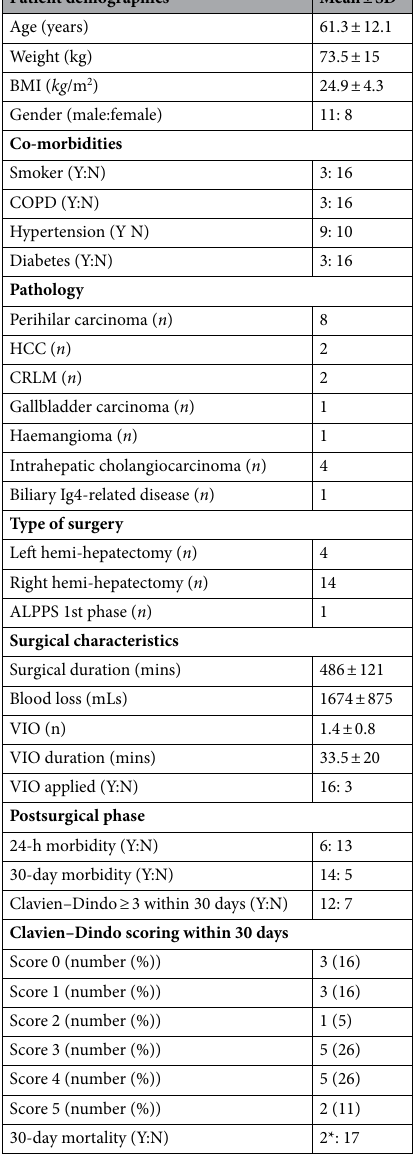
Table 1. Subject demographics, pathology, surgical profile and postsurgical phase. BMI body mass index, ALPPS Associating Liver Partition and Portal Vein Ligation for Staged hepatectomy, COPD chronic obstructive pulmonary disease, HCC hepatocellular carcinoma, CRLM colorectal liver metastasis, VIO vascular inflow occlusion. *Mortality due to